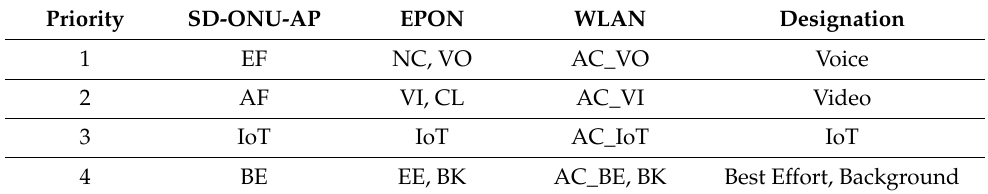
Table 1. Proposed QoS